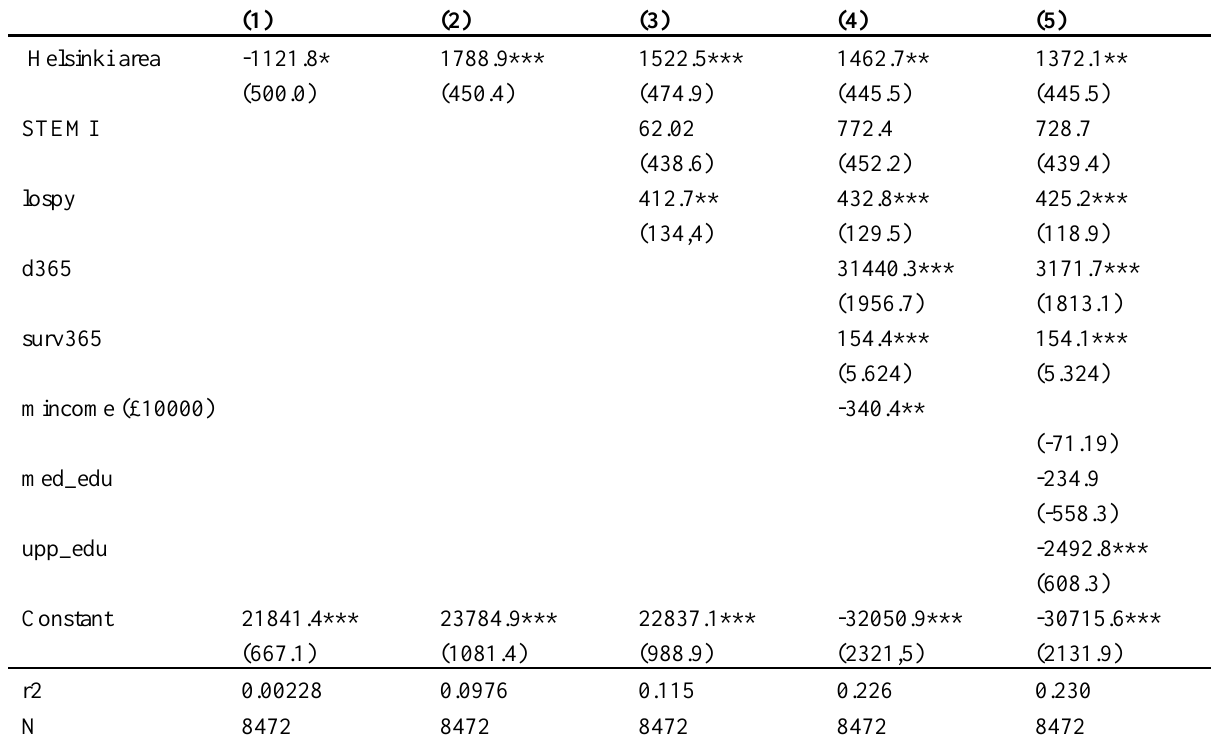
Table A4: One-year total cost comparison by OLS – the capital